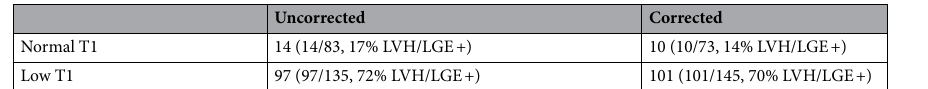
Table 4 summarizes the proportion of FD patients with other CMR signs of cardiac involvement (LVH + /-LGE). Of the patients reclassified as having low T1, 7/13 (54%) did not have any other CMR signs of cardiac involvement of Fabry disease, defined as the presence of LGE or LVH. The remaining 6/13 (46%) of reclassified patients did have LGE and/or LVH, and thus would have been identified as having cardiac involve- ment regardless of native myocardial T1 value, Fig. 2. By comparison, 3/135 (2%) of patients with low native T1 prior to blood-correction were reclassified to normal T1 following blood-correction. Of these three patients, one had no LGE or LVH, one had limited basal inferolateral LGE and LVH, and one had LVH but no LGE. In total, 2/3 of patients reclassified to normal, there were other signs of FD cardiac involvement. The two patients reclassified to normal but with other CMR signs of cardiac involvement of FD, had a native T1 marginally inside the normal range (1 and 5 ms from the cut-off limit, respectively). Native T1 did not correlate with the presence of LGE, r = 0.42, p = 0.14, nor did blood-corrected native T1, r = 0.07, p = 0.87.